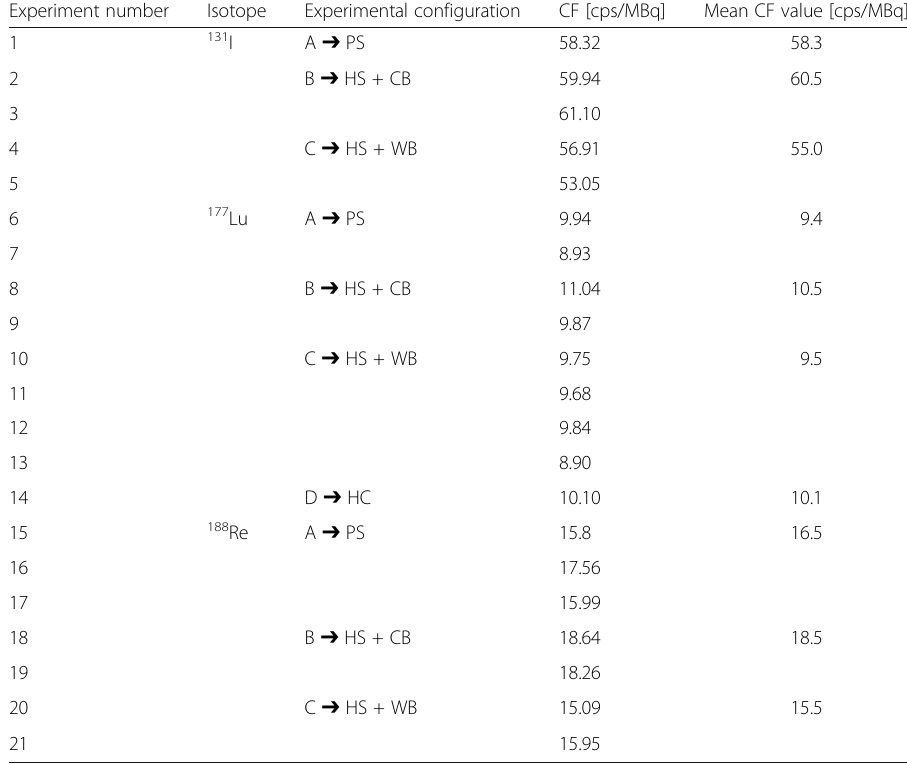
Table 7 Experimental camera CF determined using different phantom configurations Experiment number Isotope Experimental